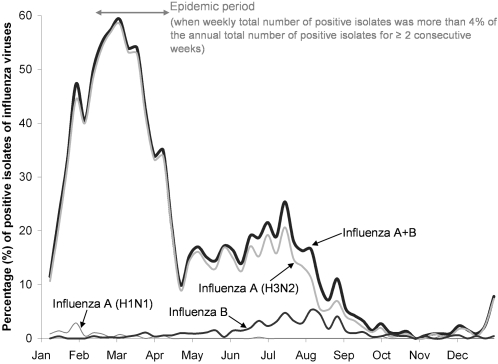
Plots of weekly proportion of total specimens positive for influenza isolation in 1998.